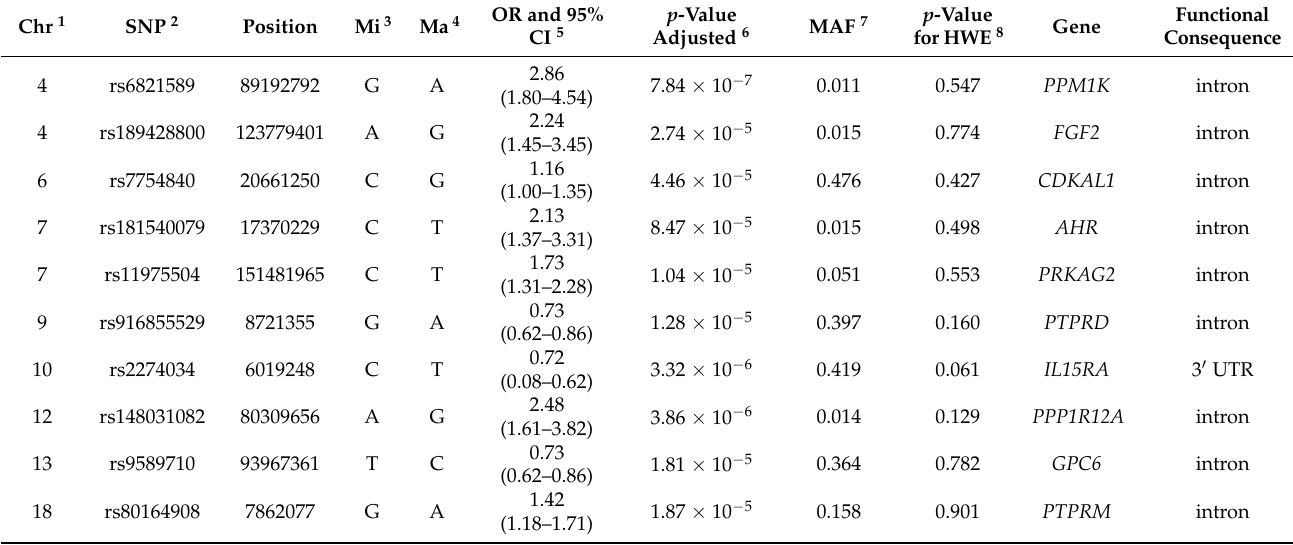
Table 3. The characteristics of the genetic variants included in the genetic variant-genetic variant interaction analysis. Chr 1